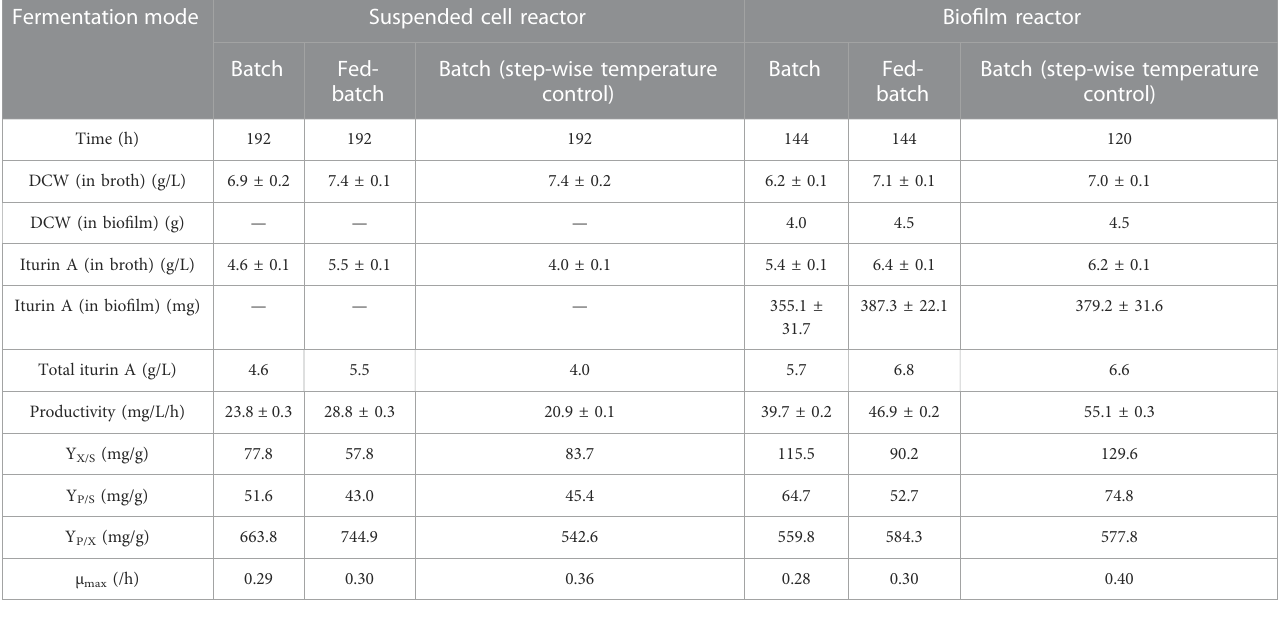
TABLE 1 Comparison of batch and fed-batch fermentation of Bacillus velezensis ND in suspended cell reactor and bio fi lm reactor. Productivity was calculated as total iturin A produced (mg/L) in a given time (h). DCW: Cell dry weight; Y X/S :Yield of biomass per glycerol; Y P/S :Yield of iturin A per carbon source; Y P/X :Yield of iturin A per biomass; μ max (in broth): Maximum speci fi c growth rate.